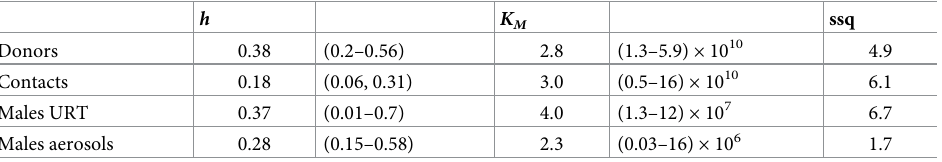
Table 3. Population level parameter estimates.